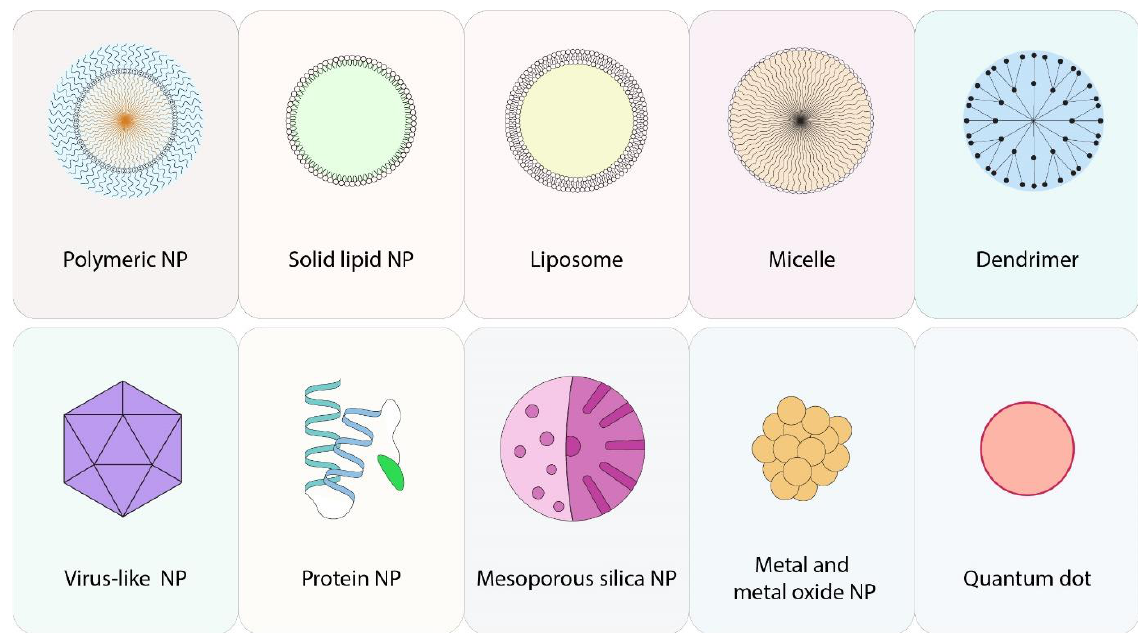
Figure 1. Various types of nanoparticles (NPs). Polymeric NPs, with the size of 1 to 10,000 nm, consist of monomers and can contain or entrap drugs or specific contents; solid lipid NPs are solid core spherical particles made from lipids with high structural stability; liposomes are artificial vesicles with at least one lipid layer with the size of 20 to 250 nm; a micelle is a colloidal particle consisting of the aggregation of amphiphilic molecules; ranging from 1.5 to 10 nm, Dendrimers are NPs with radially symmetric branches; in virus-like NPs , capsids of viruses are used as a rigid container for loading therapeutic drugs; protein NPs are composed of a therapeutic agent conjugated into a protein. Abraxane is a well-known example of protein NPs; mesoporous silica NPs are silica particles containing pores with the size of 2 to 50 nm; different metals can be used in the structure of NPs, typically in the core of NP, to improve the efficacy of drug delivery. Metal and metal oxide NPs are sensitive to many stimuli such as magnetic fields and radiation; quantum dots are artificial semiconductor nanocrystals with extensive application. In nanomedicine, quantum dots can be used as a tool for drug